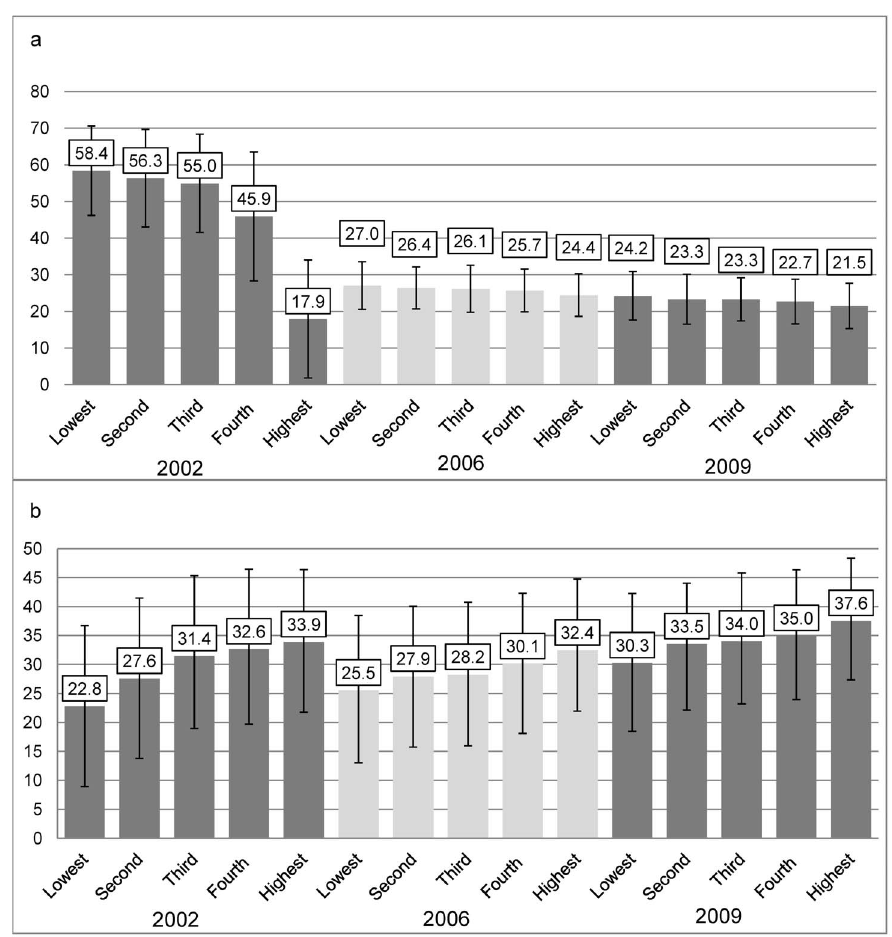
Figure 2. (a) Percent total expenditures devoted to food in 2002, 2006 and 2009, and (b) percent food expenditures devoted to ASF in 2002, 2006 and 2009, by 2002 quintiles of total expenditures. ( a ) In 2002 each quintile is significantly different from all other quintiles in that year (p , 0.05) except for the first and second quintiles, and the second and third. In 2006 each quintile is significantly different from most other quintiles in that year (p , 0.05). In 2009 the lowest quintile is significantly different from all other quintiles, and the second, third and fourth quintiles are significantly different from the highest quintile (p , 0.05). All quintiles are based on 2002 total expenditures. ( b ) In 2002 each quintile is significantly different from all other quintiles in that year except for the third and fourth quintiles, and the fourth and highest quintiles (p , 0.05). In 2006 each quintile is significantly different from all other quintiles for that year except for the second and third quintiles. In 2009 most quintiles are significantly different from all other quintiles in that year (p , 0.05). All quintiles are based on 2002 total